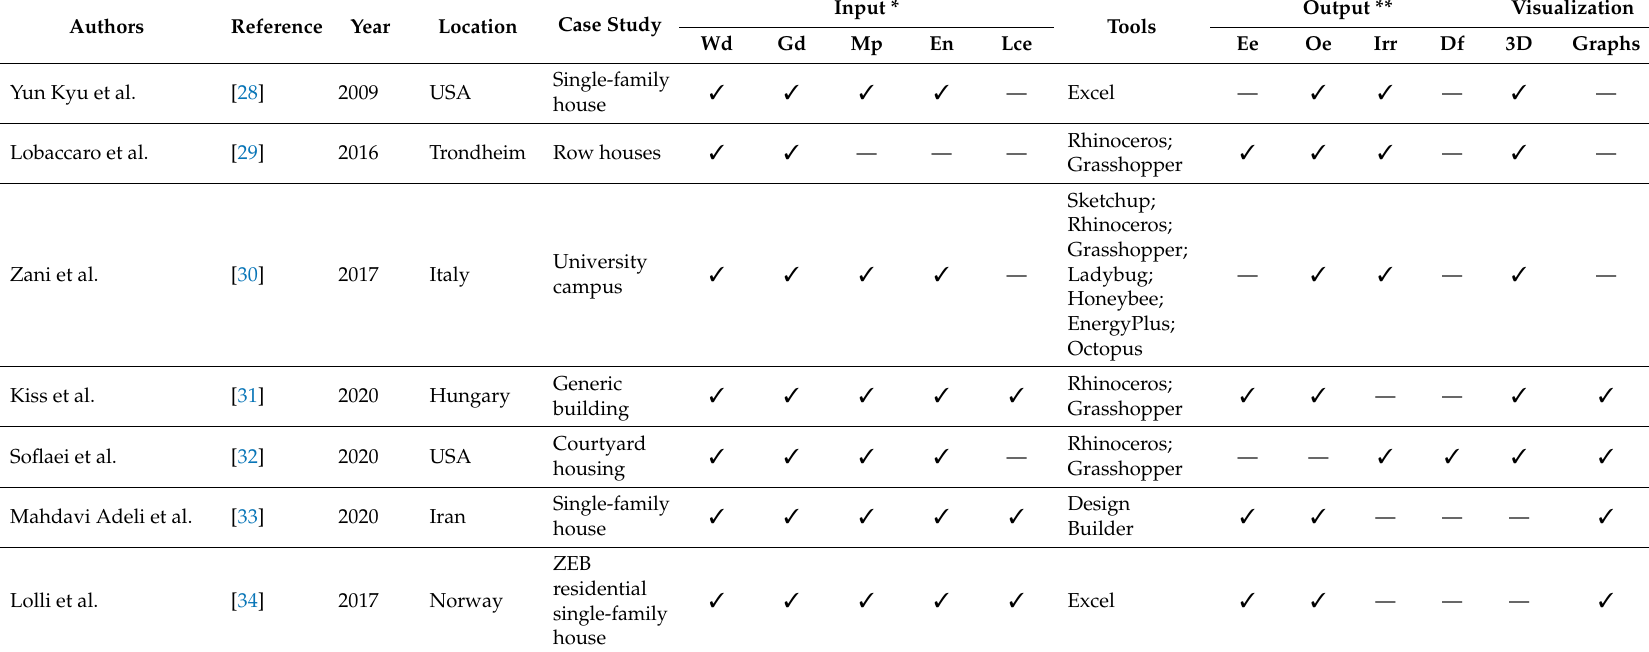
Table 1. Overview of the existing workflows related to the parametric design for multi-objective